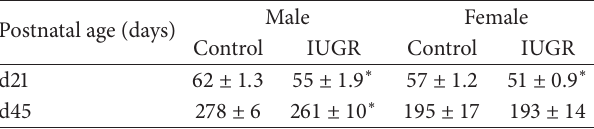
Table 1: IUGR decreased body weight (gm) in rat pups on d21 and d45 (mean ± SEM). Male Female Postnatal age (days) Control IUGR Control IUGR d21 62 ± 1.3 55 ± 1.9 ∗ 57 ± 1.2 51 ± 0.9 ∗ d45 278 ± 6 261 ± 10 ∗ 195 ± 17 193 ± 14